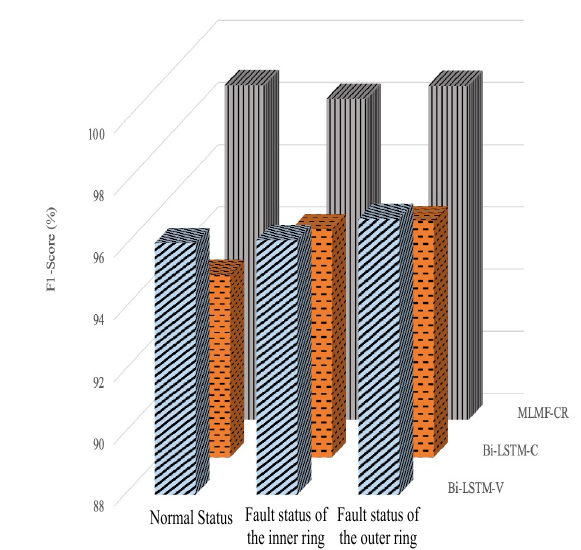
Figure 9. F1-Score indicators under different information